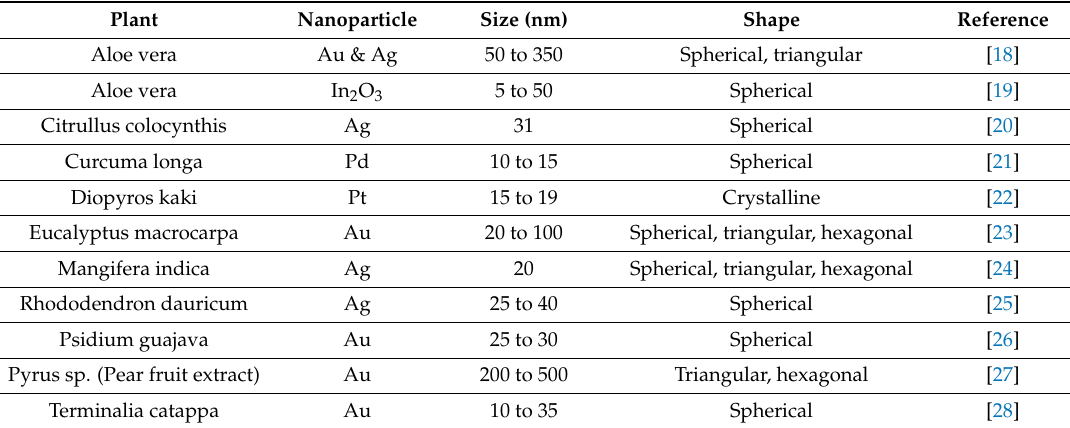
Table 2. A selection of nanoparticles synthesized by various